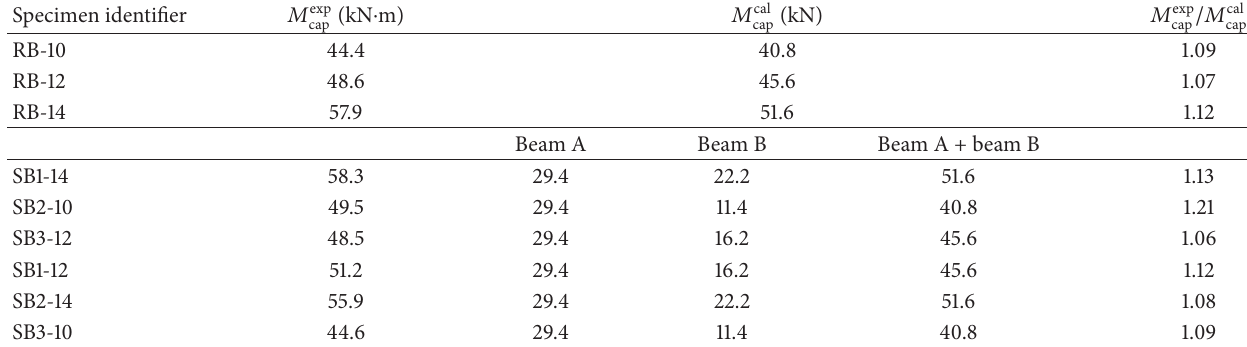
Table 6: Yield capacities of the